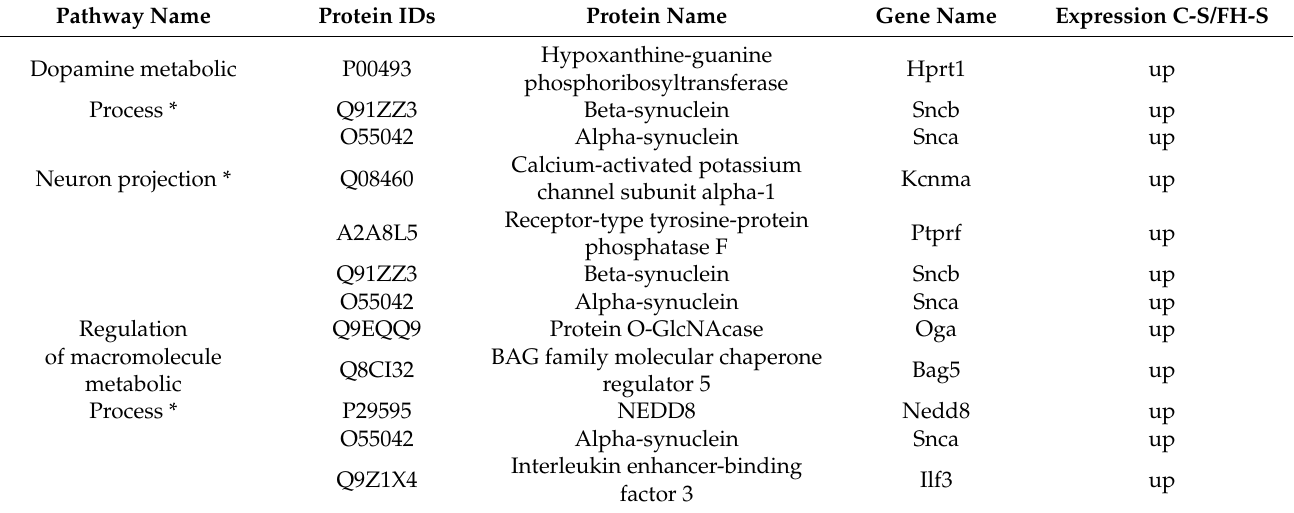
Table 3. Pathways and associated proteins upregulated by acute mild